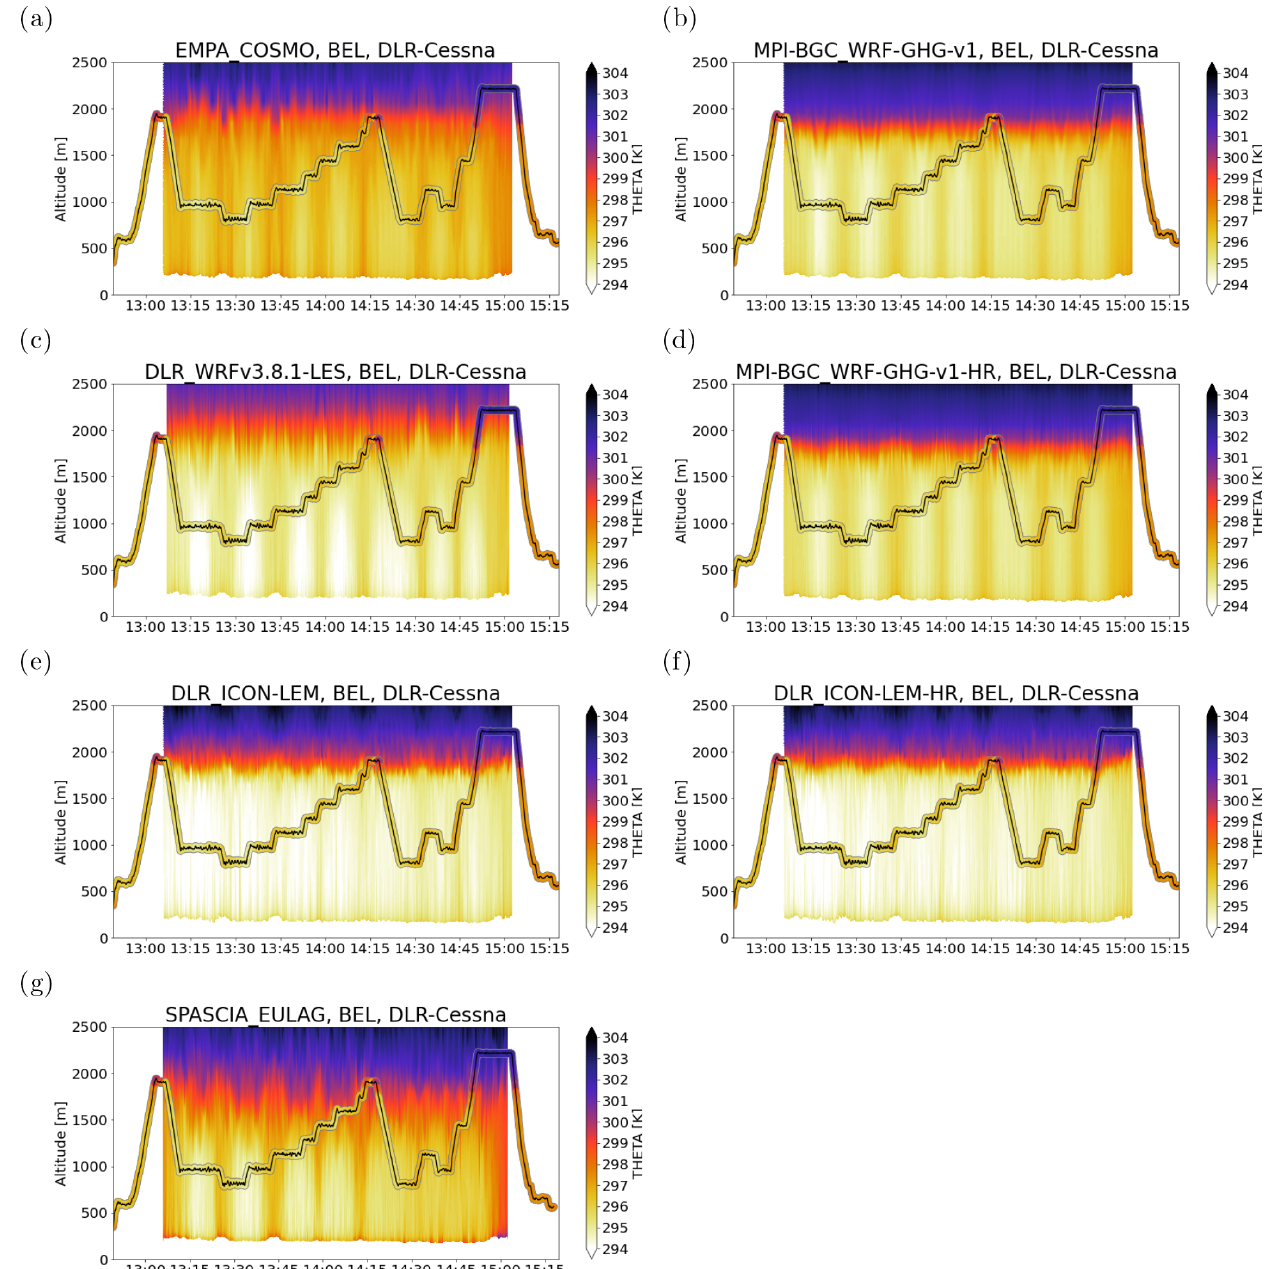
Figure 5. Curtains of potential temperature along the DLR Cessna flight on 7 June 2018.